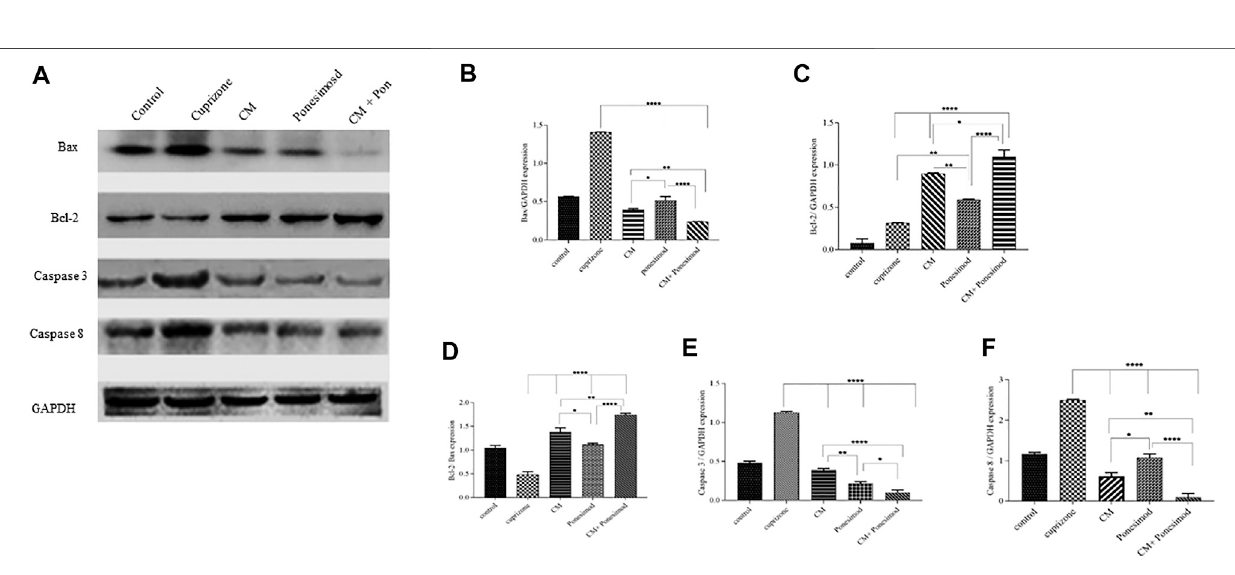
Frontiers in Pharmacology |